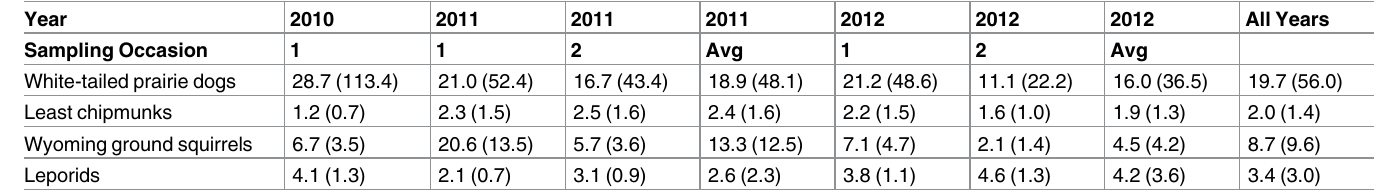
Table 3. Occasion-specific density estimates (individuals/km 2 ; standard deviation in parentheses) averagedover all sampled sites for the most abundant small mammal species groups modeled from line transect surveysin Wyoming, 2010–2012.